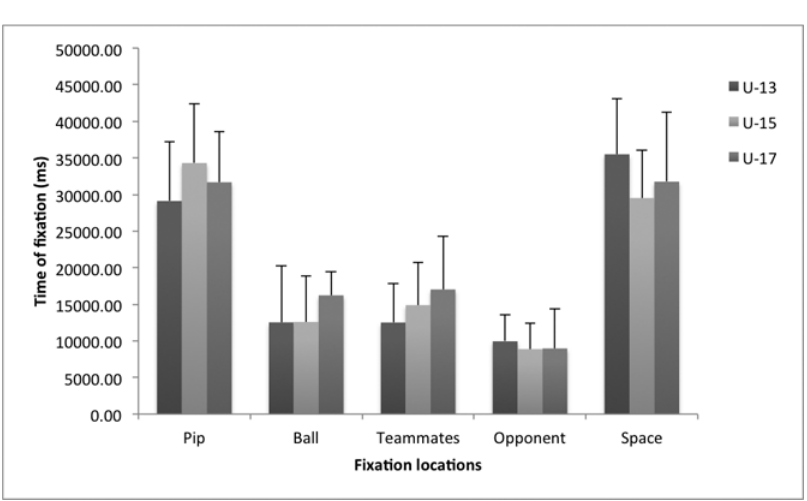
Figure 2. Means and standard deviation for the time of fixations made by each group in pre-defined locations in the video